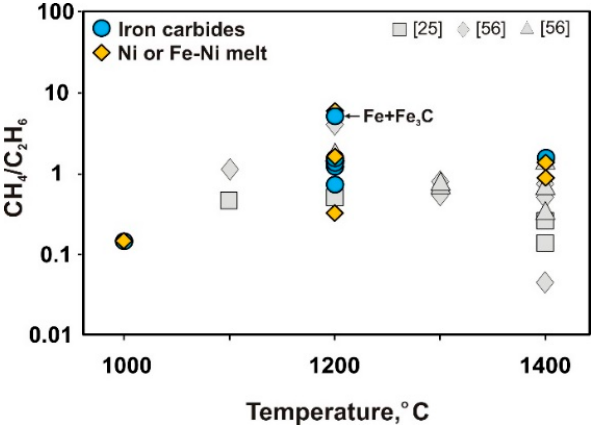
Figure 3. CH 4 /C 2 H 6 ratio in quenched fluids obtained in this study by interaction of metal phases with different carbon sources (blue circles and yellow diamonds) and in previous studies [25,56] by thermal destruction of docosane (gray diamonds) or stearic acid (triangles), and by hydrogenation of graphite (squares).